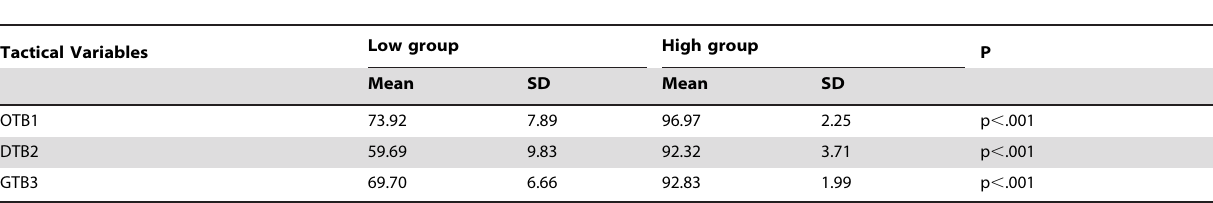
Table 1. Descriptive values of the tactical behavior of participants.